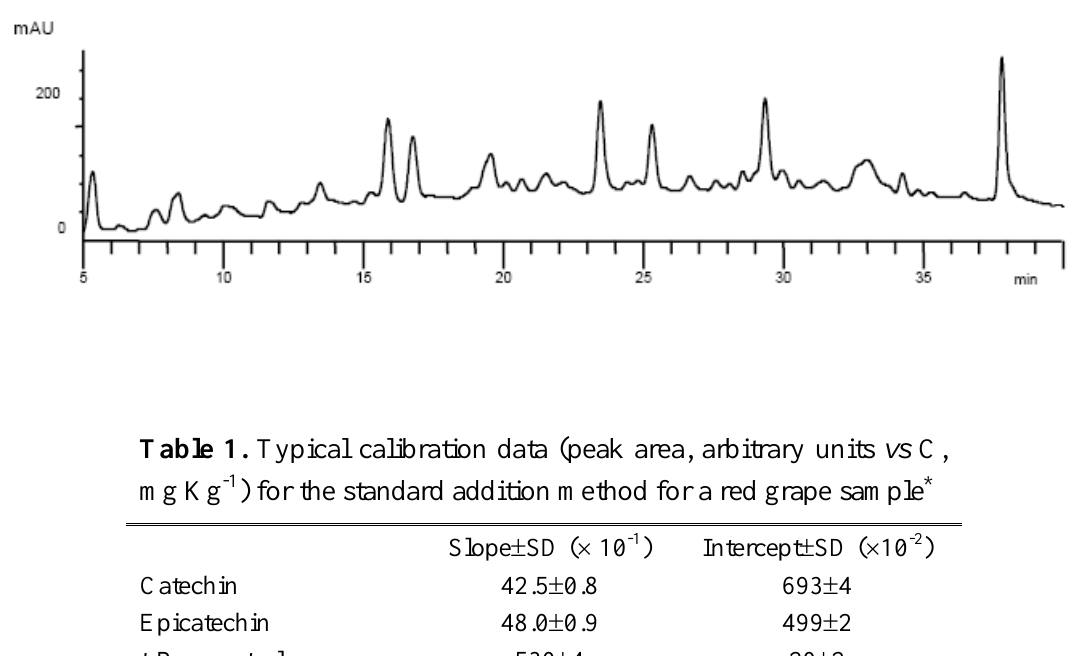
Figure 3. Chromatogram acquired during the analysis of red grape berries of the Vertzami variety after hydrolysis, as described in the sample preparation sub section, of glycosidic bonds of sub-sample.